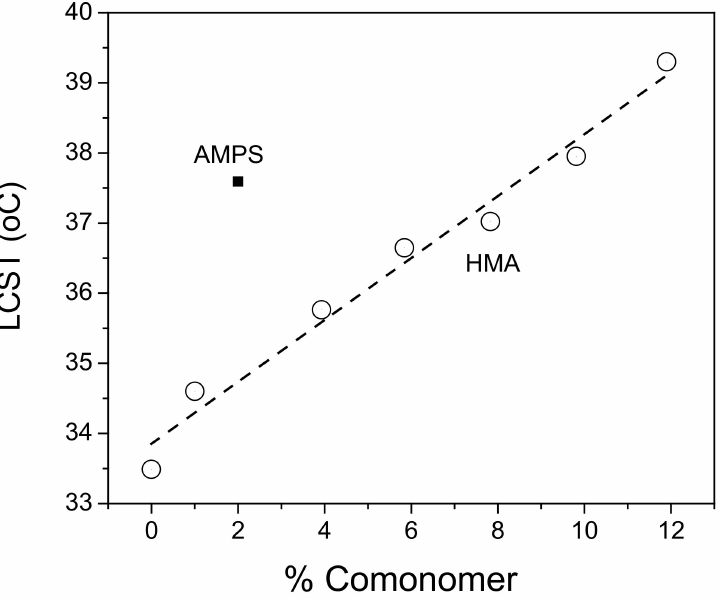
Figure 5. Effect of copolymer composition on the LCST of PNIPAM-based materials. Open circles correspond to P(NIPAM-co-x%HMA) (x% is the percentage of comononer) while the filled square corresponds to